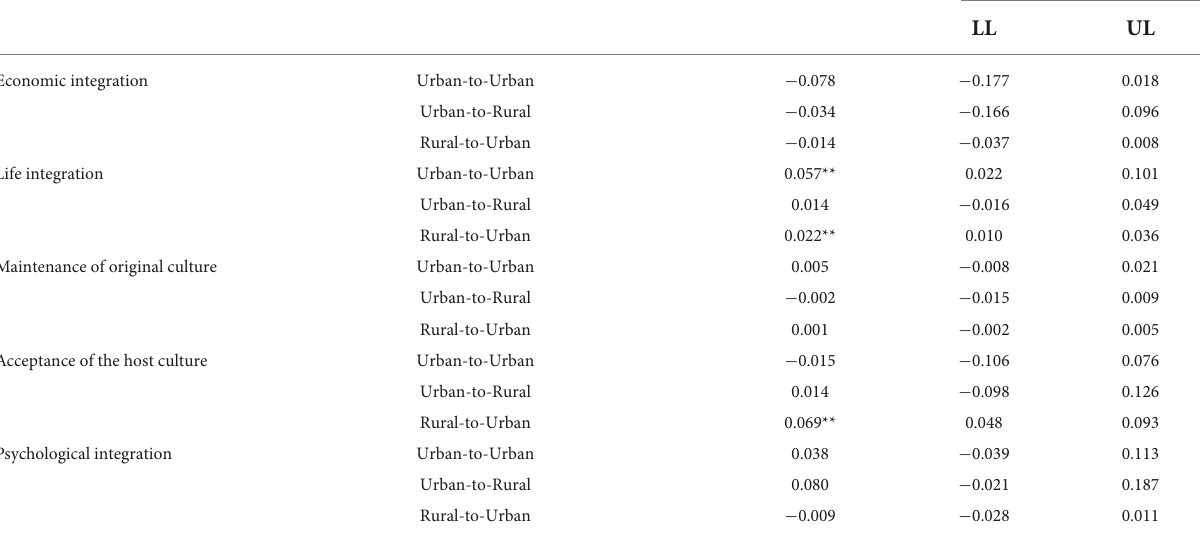
TABLE 3 The mediating effect of social integration on the association between migration paths and psychological distress of new-generation